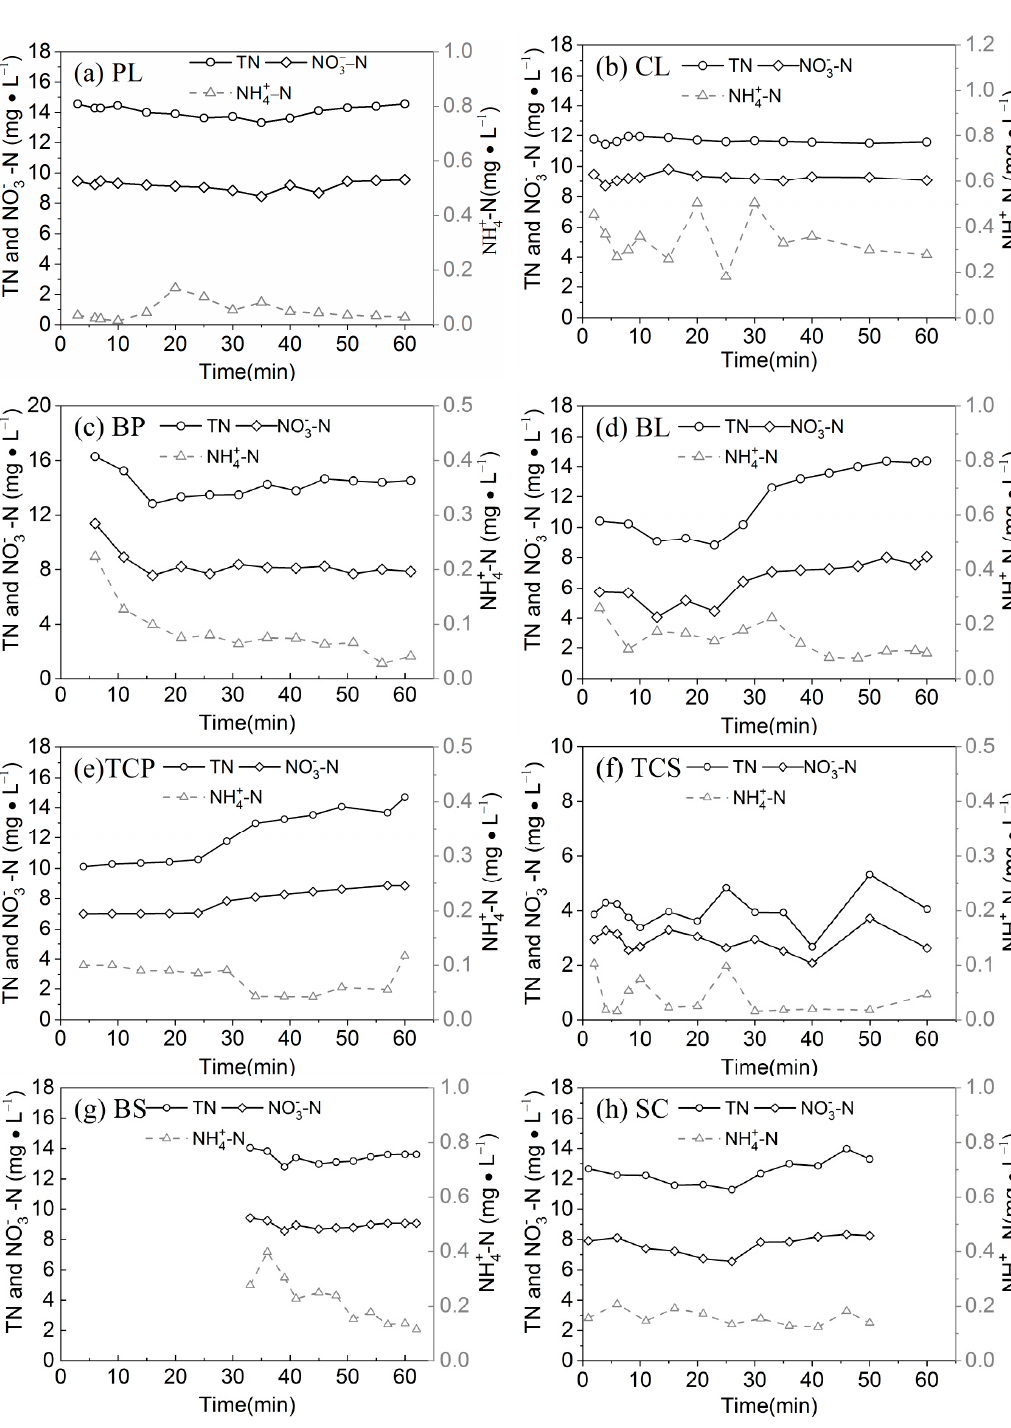
–N, and NH + –N, and NH + 3 3